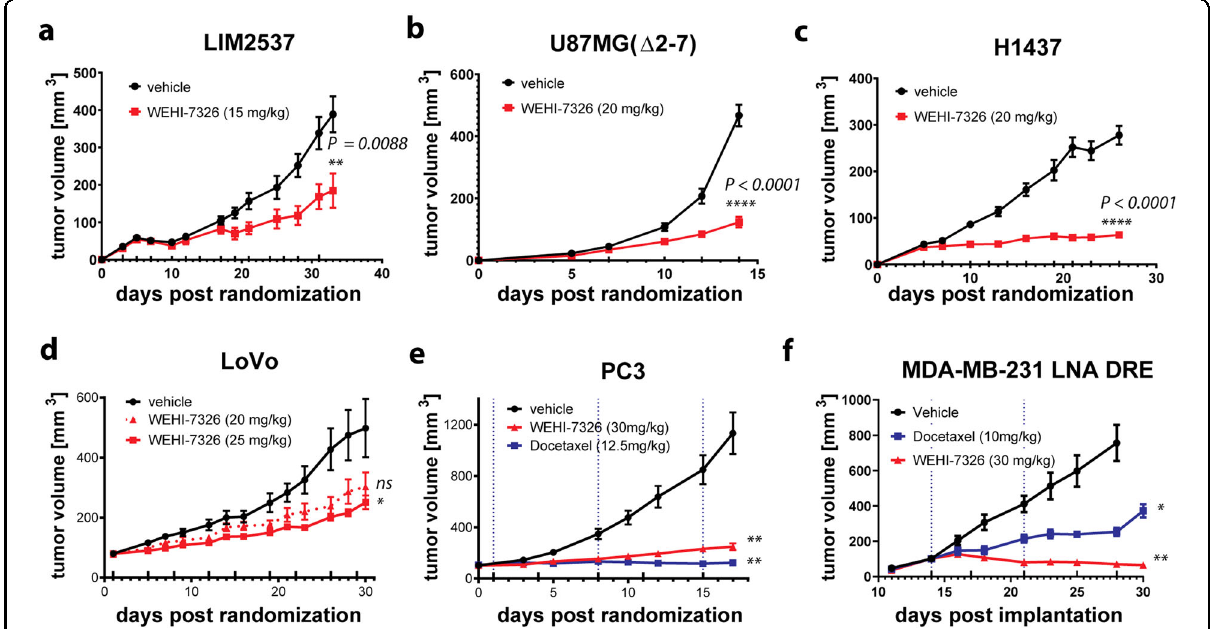
Fig. 3 WEHI-7326 reduces the growth of multiple tumor types in xenograft models. Tumor growth curves of tumor xenografts in Balb/c nude mice. a – c LIM2537 (colon carcinoma), U87MG( Δ 2 – 7) (glioblastoma) or H1437 (non-small cell lung carcinoma) were implanted subcutaneously in female mice. Treatment with vehicle or WEHI-7326 was initiated at day 5 and administered three times weekly via intraperitoneal injection. Tumor diameters were measured thrice weekly and used to calculate tumor volume. Data show mean±SEM ( n = 8). d LoVo (colon carcinoma) in male mice. Treatment with vehicle or WEHI-7326 (biweekly) was administered via tail vein injection. Tumor diameters were measured twice weekly and used to calculate tumor volume. Data show mean±SEM ( n = 5). e PC3 (human prostate carcinoma) in male mice. Treatment with vehicle (saline), Docetaxel (weekly) or WEHI-7326 (biweekly) was administered via tail vein injection. Tumor diameters were measured twice weekly and used to calculate tumor volume. Vertical line in left graph show docetaxel treatment. Data show mean ± SEM ( n = 10). f MDA-MB-231 LNA DRE (docetaxel resistant breast cancer) in female mice. Treatment with control vehicle, docetaxel (weekly) or WEHI-7326 (biweekly) was administered via tail vein injection. Tumor diameters were measured thrice weekly and used to calculate tumor volume. Vertical line in left graph show docetaxel treatment. Data show mean ± SEM ( n = 12). Upward ticks on x-axis depict drug administration points for WEHI-7326, dotted blue lines for docetaxel. P -values for differences in tumor volume (compared to vehicle) were generated via unpaired t -tests; p > 0.05 (ns), p < 0.05 (*), p < 0.01 (**) and p < 0.0001